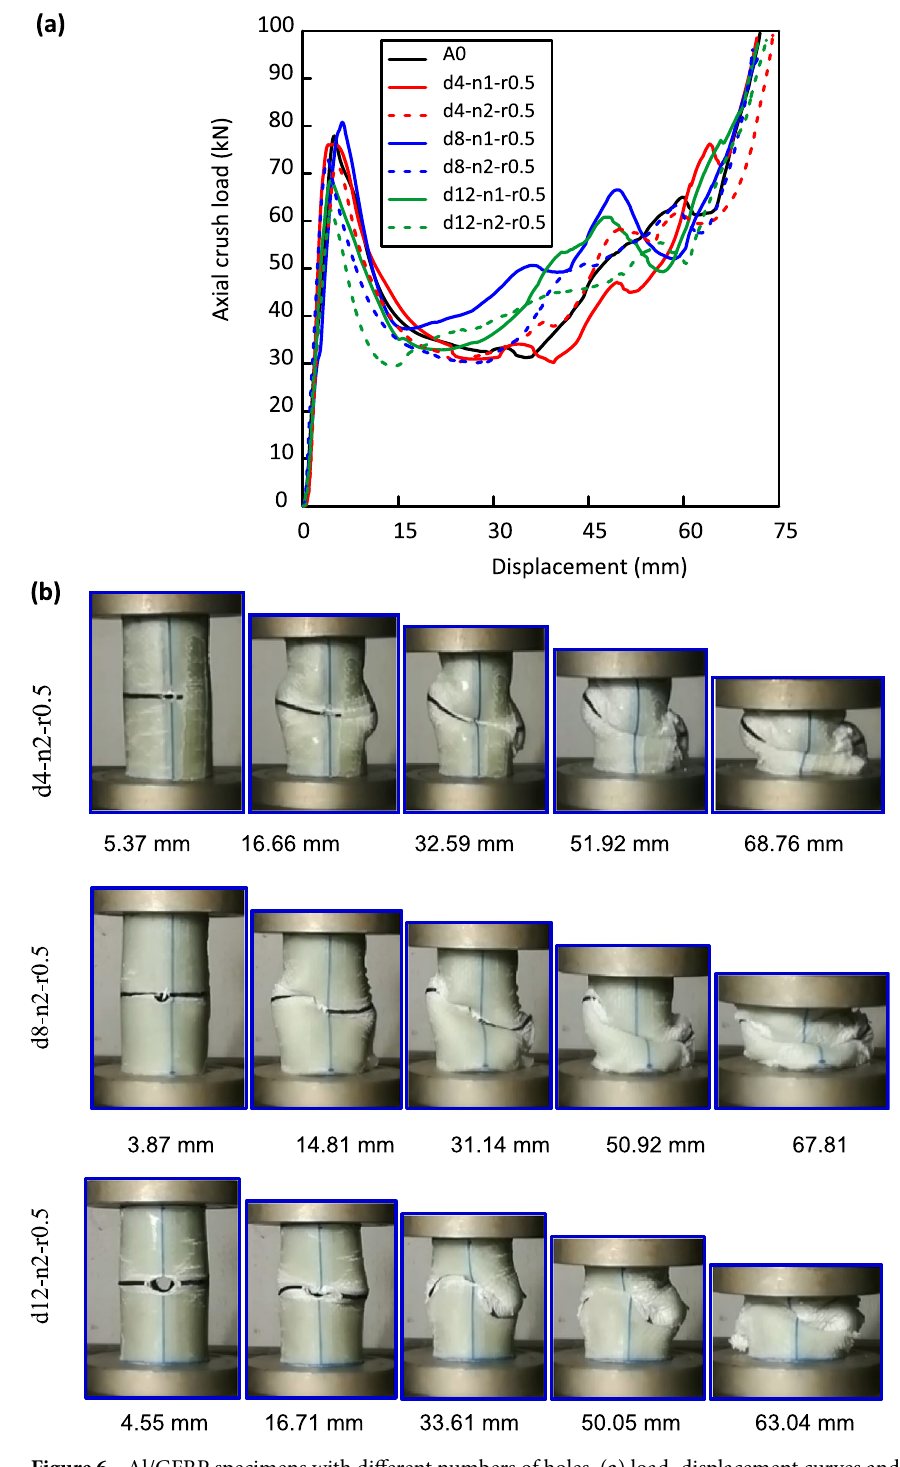
Figure 6. Al/GFRP specimens with different numbers of holes, ( a ) load–displacement curves and ( b ) crushing